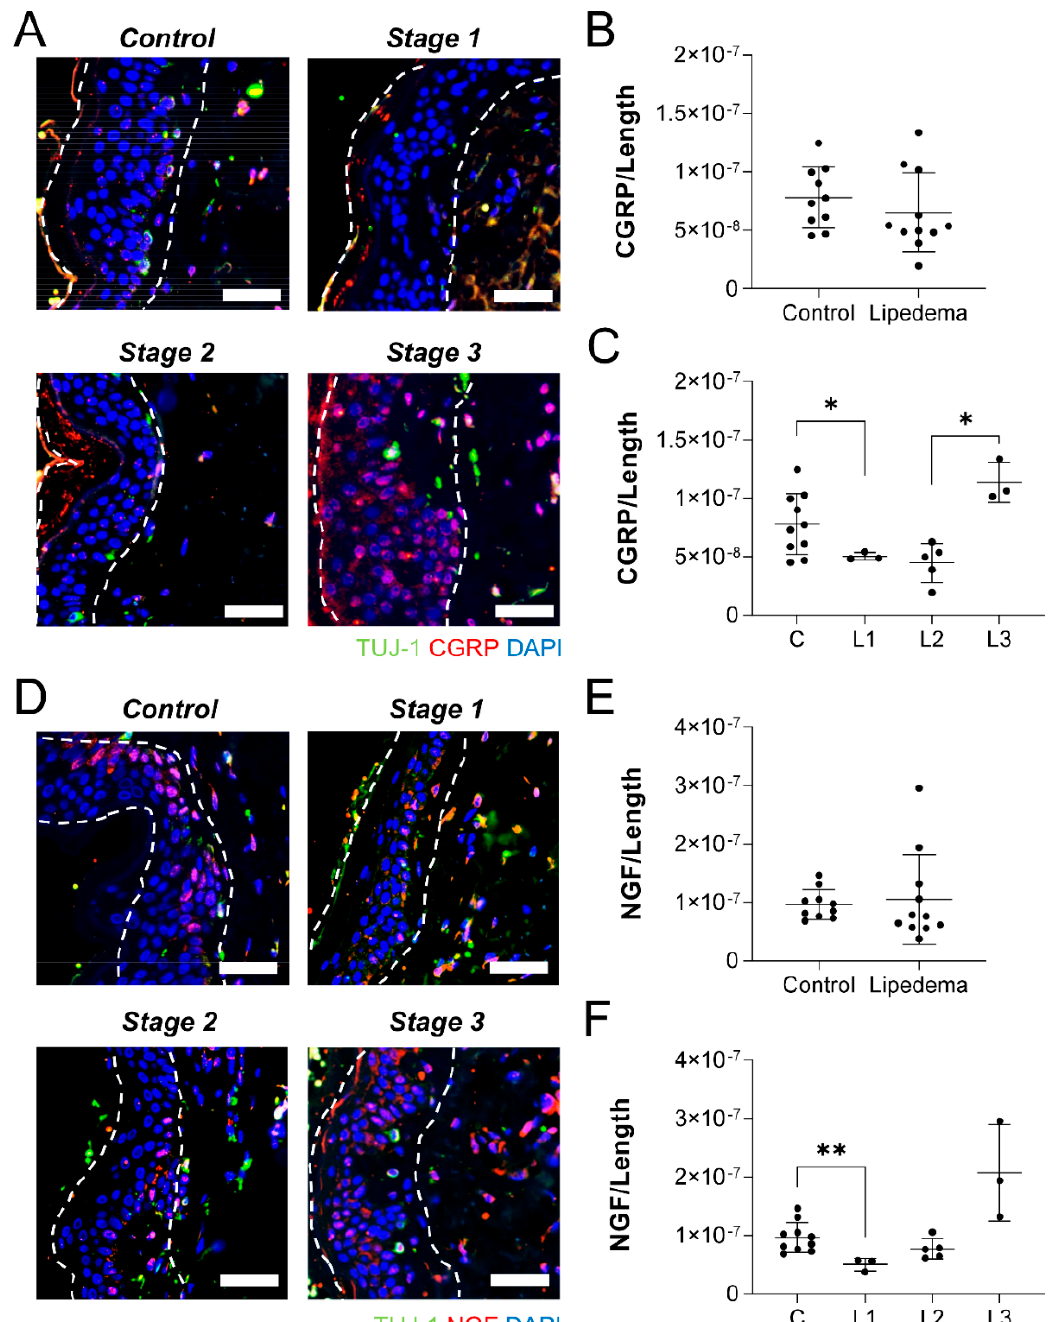
Figure 5. Lipedema stage-based characterization of neuropathic markers in abdomen dermal sections. ( A ) Tuj1+ (green), CGRP (red), and nuclei (blue) in abdominal dermis of stage 1, 2, and 3 lipedema. ( B ) CGRP fluorescence threshold normalized to the total length of the tissue in control and total lipedema patients. ( C ) CGRP fluorescence threshold normalized to the total length of the tissue in control and stage 1, 2, and 3 lipedema patients ( p = 0.0108 across stages by ANOVA). ( D ) Tuj1+ (green), NGF (red), and nuclei (blue) in abdominal dermis of stage 0,1, 2, and 3 lipedema. ( E ) NGF fluorescence threshold normalized to the total length of the tissue in control and total lipedema patients. ( F ) NGF fluorescence threshold normalized to the total length of the tissue in control and stage 1, 2, and 3 lipedema patients ( p = 0.0977 across stages by ANOVA). ( A – F ) Control n = 10, Stage 1 n = 3, Stage 2 n = 5, Stage 3 n = 3. Bars = 100 µm. Mean ± SD. * p < 0.05 and ** p < 0.01 by post hoc multiple comparison test.